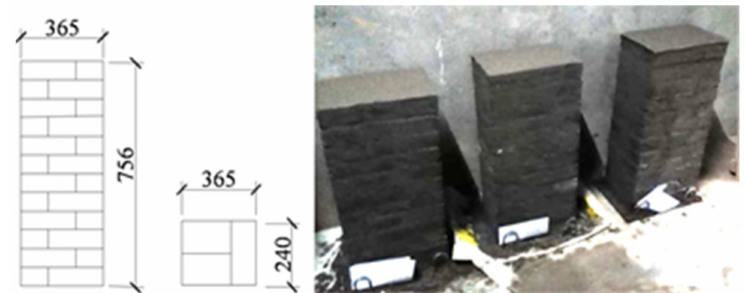
Figure 1. Size of autoclaved fly-ash-brick short columns.